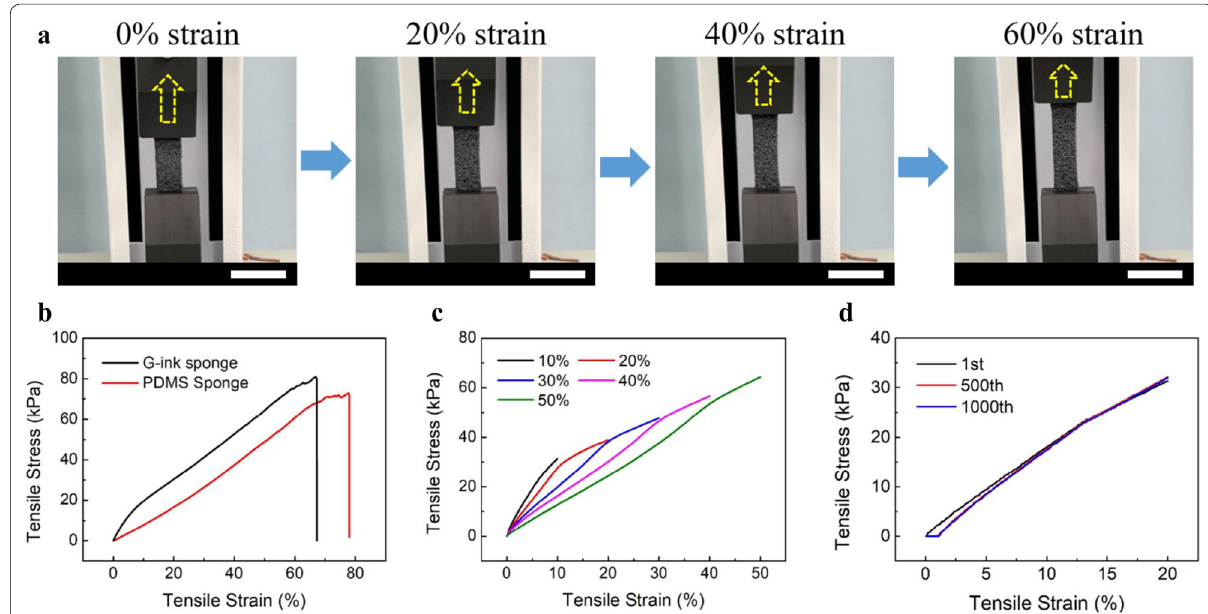
Fig. 4 Mechanical evaluation of the graphene-coated PDMS sponge. a Evaluation images when graphene-coated PDMS sponge is stretched from 0 to 60%. b The measured tensile stress–strain curves of bare and graphene-coated PDMS sponges. c The tensile stress–strain curves under different maximum strain range (from 10 to 50%). d The measured results of 1000 cycles on 20%